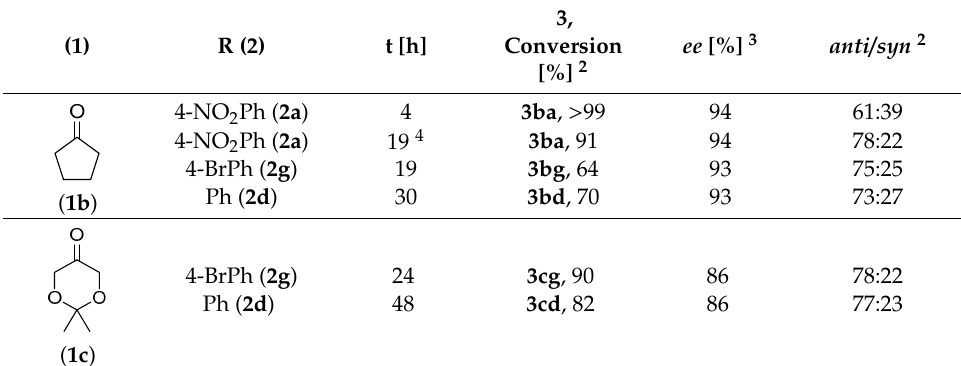
Table 5. MeOH / H 2 O / ( S )-proline-based protocol applied to ketones 1b,c 1 . Table 5. MeOH/H 2 O/( S )-proline-based protocol applied to ketones 1b,c 1 . Table 5. MeOH/H 2 O/( S )-proline-based protocol applied to ketones 1b,c 1